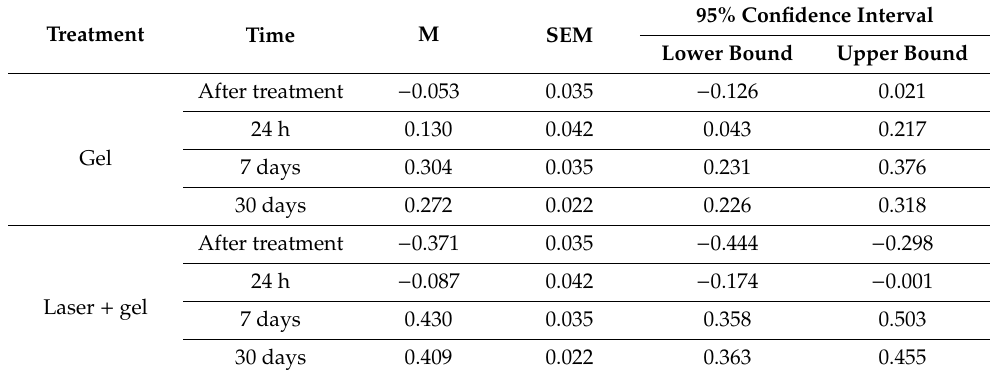
Figure 7. Estimated e ff ect size for the two treatments in the very short and medium term. For the numerical values on the vertical axis, the null stands to the left of the decimal point. Table 9. Estimated treatment e ff ect as the relative di ff erence between the post-treatment flowmetry values and the initial recorded values.